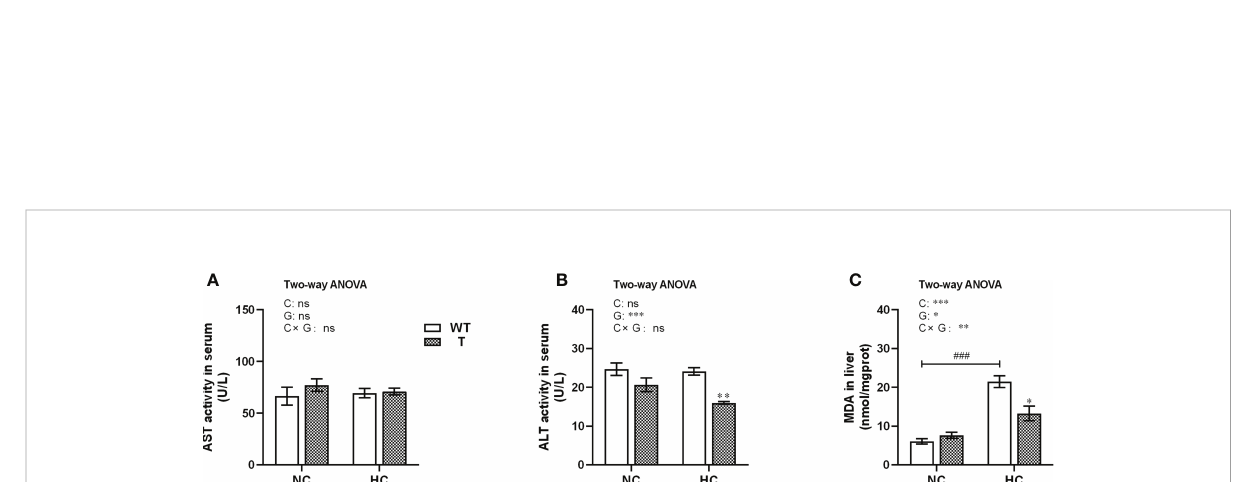
FIGURE 7 Lipid accumulation in the liver of T and WT common carp fed a normal or high-carbohydrate diet. (A) Liver sections stained with Oil Red O. Scale bars, 25 m m (40×). (B) Relative lipid droplet areas in the liver. (C, D) Total lipid and triglyceride contents in the liver (n = 6). *, ** and *** indicate a signi fi cant difference ( P < 0.05, P < 0.01, and P < 0.001, respectively) in different strains at same dietary starch content. #, ## and ### indicate a signi fi cant difference ( P < 0.05, P < 0.01, and P < 0.001, respectively) in the same strain with different dietary starch contents. In two-way ANOVA, C, carbohydrate; G, GH. *** P < 0.001; ns, indicates no signi fi